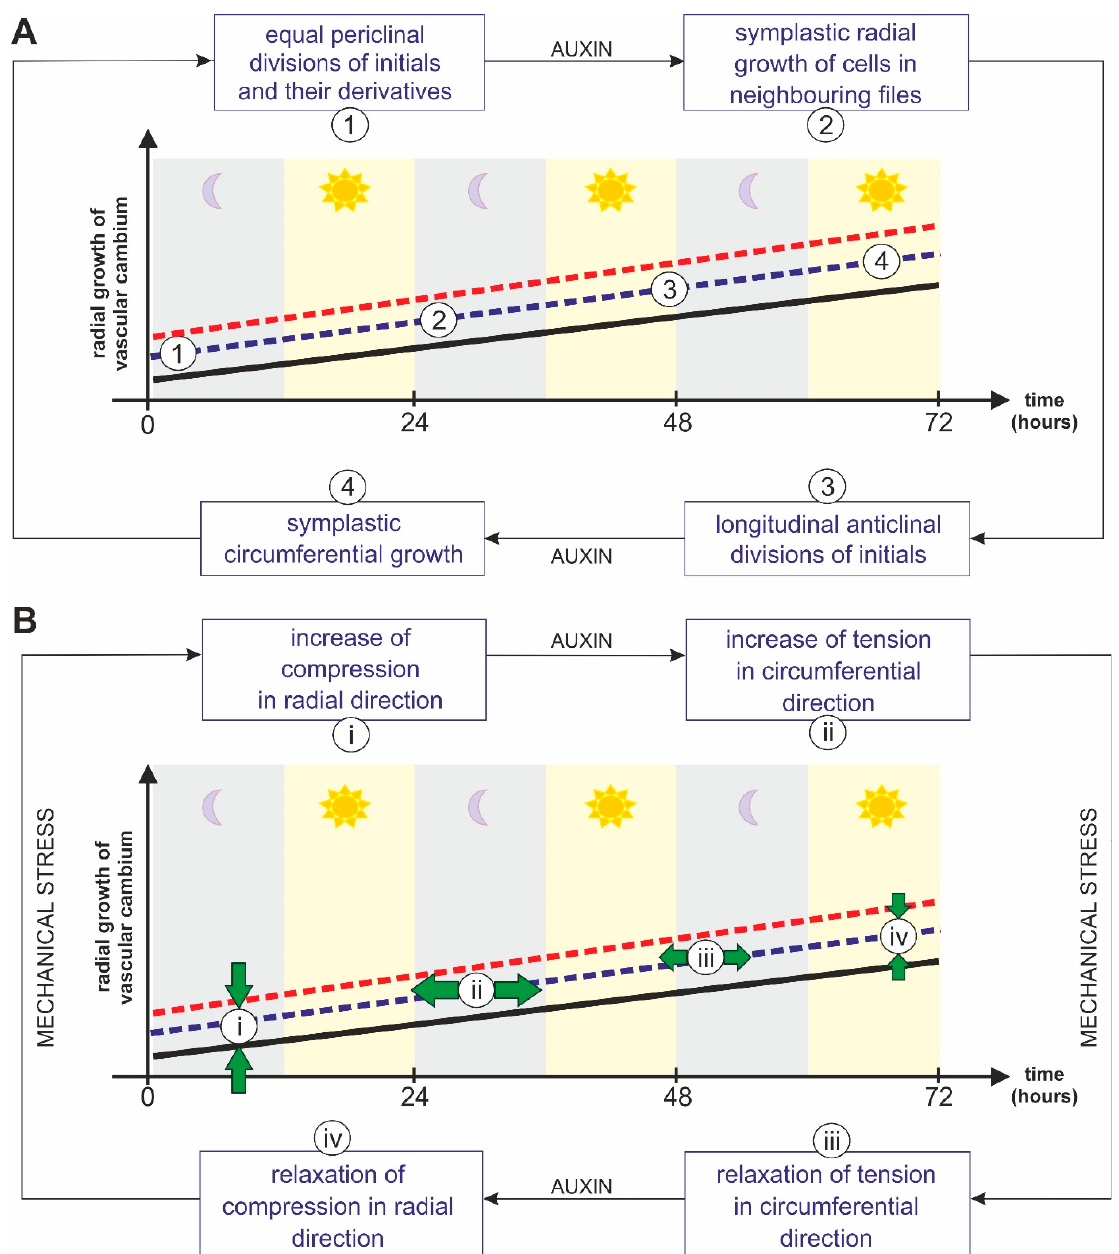
Figure 2. Scheme summarising the previous understanding of the mechanism of radial growth of the vascular cambium. ( A ) Basic cellular events involved in radial growth of the vascular cambium: (1) equal periclinal divisions; (2) radial growth; (3) longitudinal anticlinal divisions; (4) circumferential growth. ( B ) Mechanical stress involved in radial growth of the vascular cambium. Radial growth generates (i) compressive stress in the radial direction and is responsible for (ii) an increase in tensile stress in circumferential direction. The growth in circumferential direction (iii) reduces the tensile stress in circumferential direction and thus (iv) decreases the compression in radial direction below the inhibitory value of radial growth, allowing further radial growth of the cambial cells. Blue dashed line—vascular cambium. The radial growth of the phloem (red dashed line) and xylem (black line) is included. In this approach, the radial growth of the vascular cambium is induced by auxins and is not dependent on diurnal rhythms, which are marked as grey (night) and yellow (day) stripes. A period of 72 h was chosen based on the mathematical modelling concerning an average cambial initial in 1 m circumference cambial cylinder that deposited 3 mm thick annual ring—it was calculated that, on average, each initial cell divides periclinally approx. every third day [28].